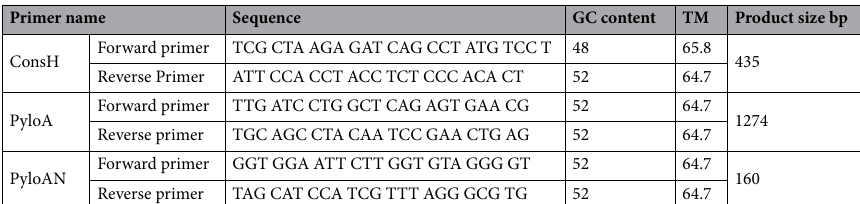
BFHpyl gave positive with only one Helicobacter ( H. pylori 26695 and H. pylori G27, respectively). 16srRNA (b) and Heid didn’t produce any bands with all Helicobacters. Laboratory comparative study. H276, outer/inner, Hcom1, Heli-nest/HeliS, and 16srRNA (a) yielded posi- tive results with all eight Helicobacters, 16srRNA (b) relented positive results with six Helicobacters, BFHpyl revealed a positive band with only one H. pylori while Heid primer gave negative with all Helicobacter spp. Non-specific results were obtained with other Non-helicobacters as follows: H276 ( S. mutans) , Heli-nest/HeliS ( Salmonella spp. ), Hcom1 and BFHpyl ( K. pneumonae ) , 16srRNA (a) ( E. fecalis ), Heid ( E. coli) while outer/inner primer gave positive results with all non-helicobacters. Statistical evaluation of the diagnostic utility of different 16srRNA primers for Helicobacter spp. detection. ConsH matched all criteria considered for the gold standard selection. The statistical evaluation parameters accord- ing to in silico PCR amplification are described in Table 3. The outer/inner primers had 100% specificity and sensitivity with a P -value of 0.0001. Hcom1, H276, and HeliS/Heli-nest had 50% SP. The utility is measured also by the receiver operating characteristics (ROC) analysis expressed by the area under the curve (AUC), the ROC analysis of the in silico evaluation is demonstrated in Fig. 1. The laboratory evaluation showed 0.00% SP with heminested outer/inner primers with P -value=1. The H276, 16srRNA(a), HeliS/Heli-nest, and Hcom had